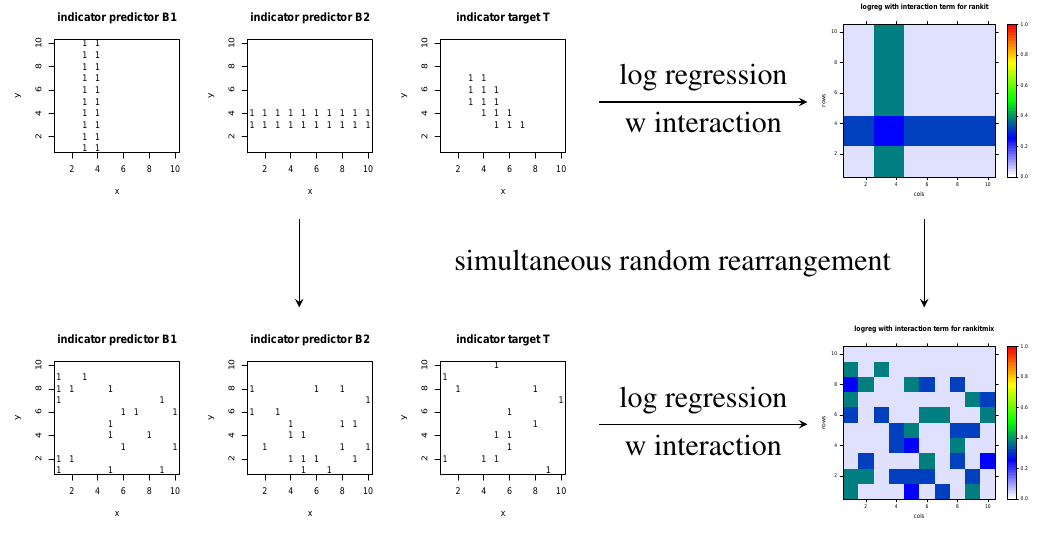
Figure 4. Commutation of targeting and simultaneous random rearrangement of all digital map